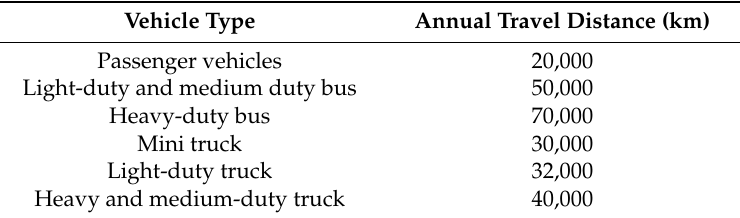
Table 2. The life-long travel distance of each type of vehicles.